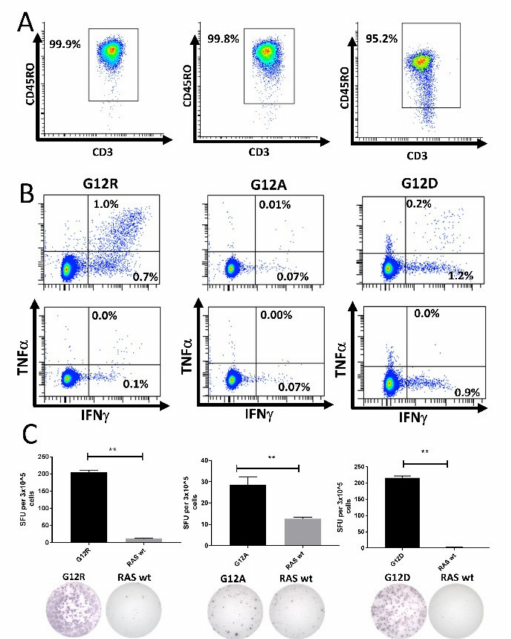
Figure 4. High-purity cultures of CD4 + CD45RO + memory T cells respond to stimulation with mutant RAS epitopes without cross-reactivity to the wild-type (wt) epitope. Left: Healthy donor BM-56; middle: Healthy donor BM-59; right: Healthy donor BM-65. ( A ) Purity analysis of the enriched CD4 + CD45RO + memory T cells mixed with peptide-pulsed, autologous CD14 + monocytes. The gate was set for live CD3 + CD4 + cells to investigate the purity of the enriched cells. ( B ) Fluorescence-activated cell sorting (FACS) plots from an intracellular cytokine stain in which enriched memory cells were stimulated with mutant epitope (top) or wt epitope (bottom). ( C ) IFN- γ ELISPOT assays with a graphical depiction of the response (top) and representative wells from the experiment (bottom). ** indicates a DFR(2x) defined response